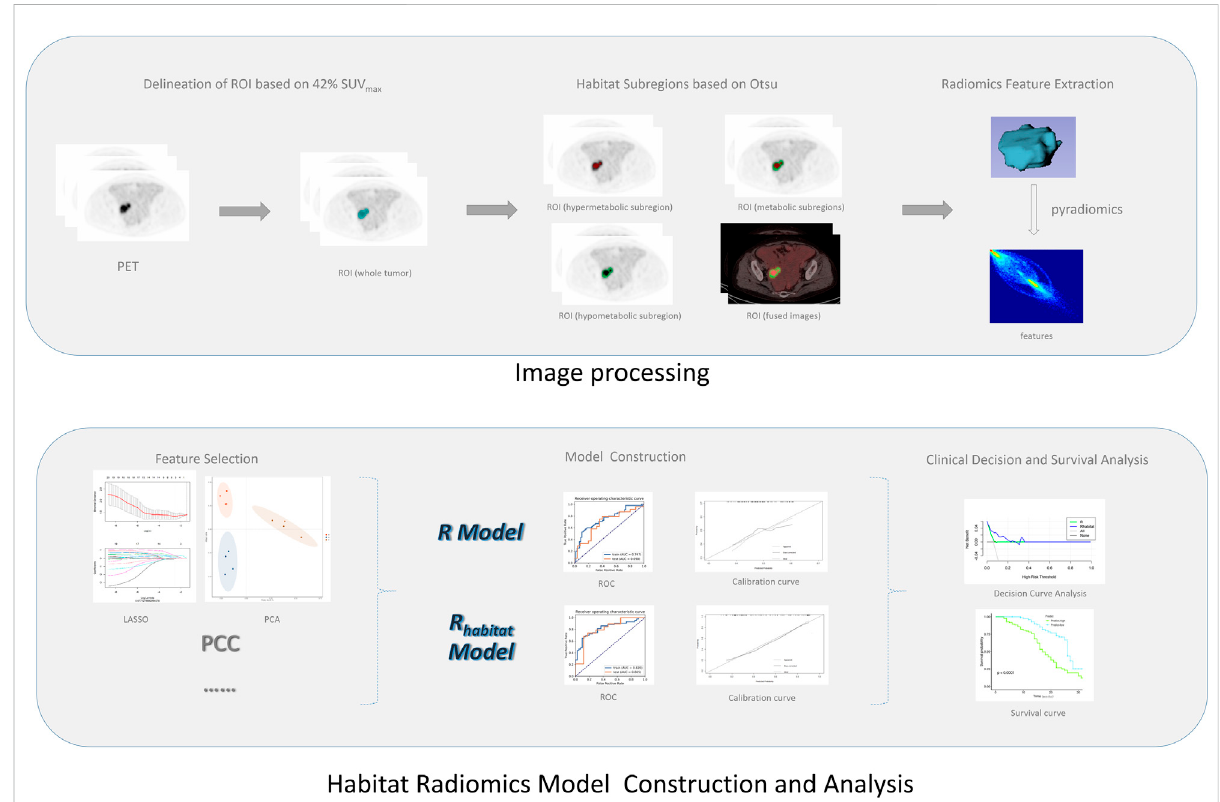
FIGURE 1 Schematic diagram of study